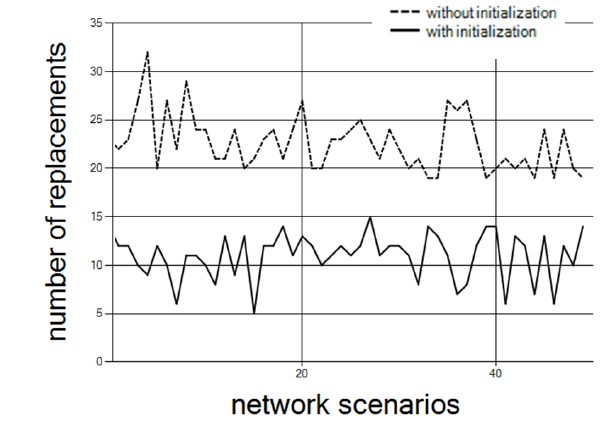
Figure 10. Number of replacements with and without